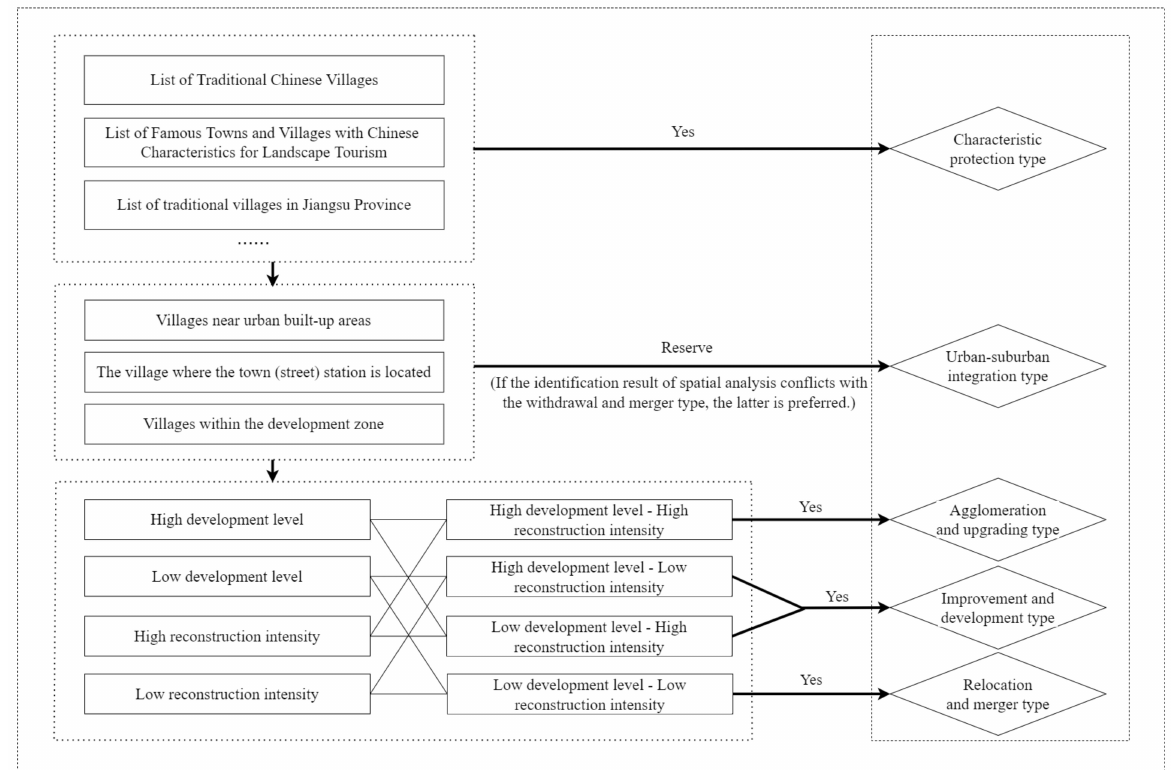
Figure 2. Framework of village type